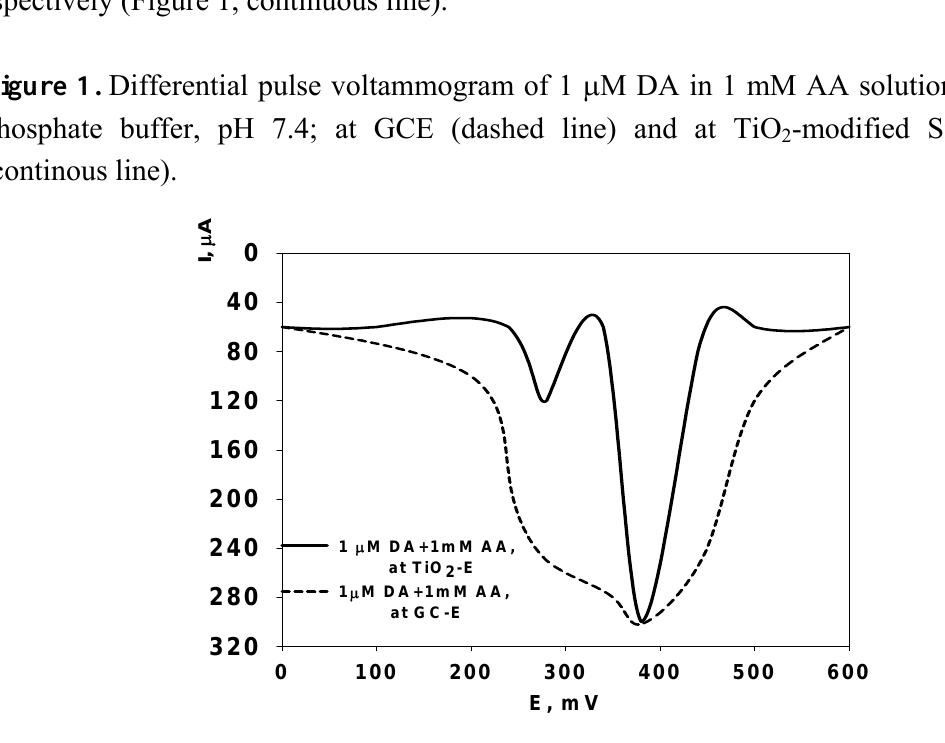
-modified Si electrode 2